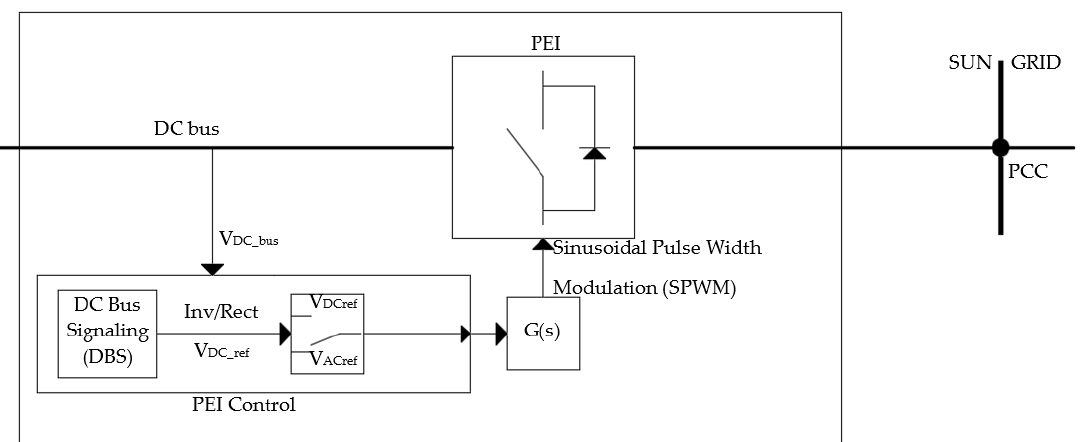
Figure 2. Control scheme of Power Electronic Interface (PEI) Local Controller (LC).